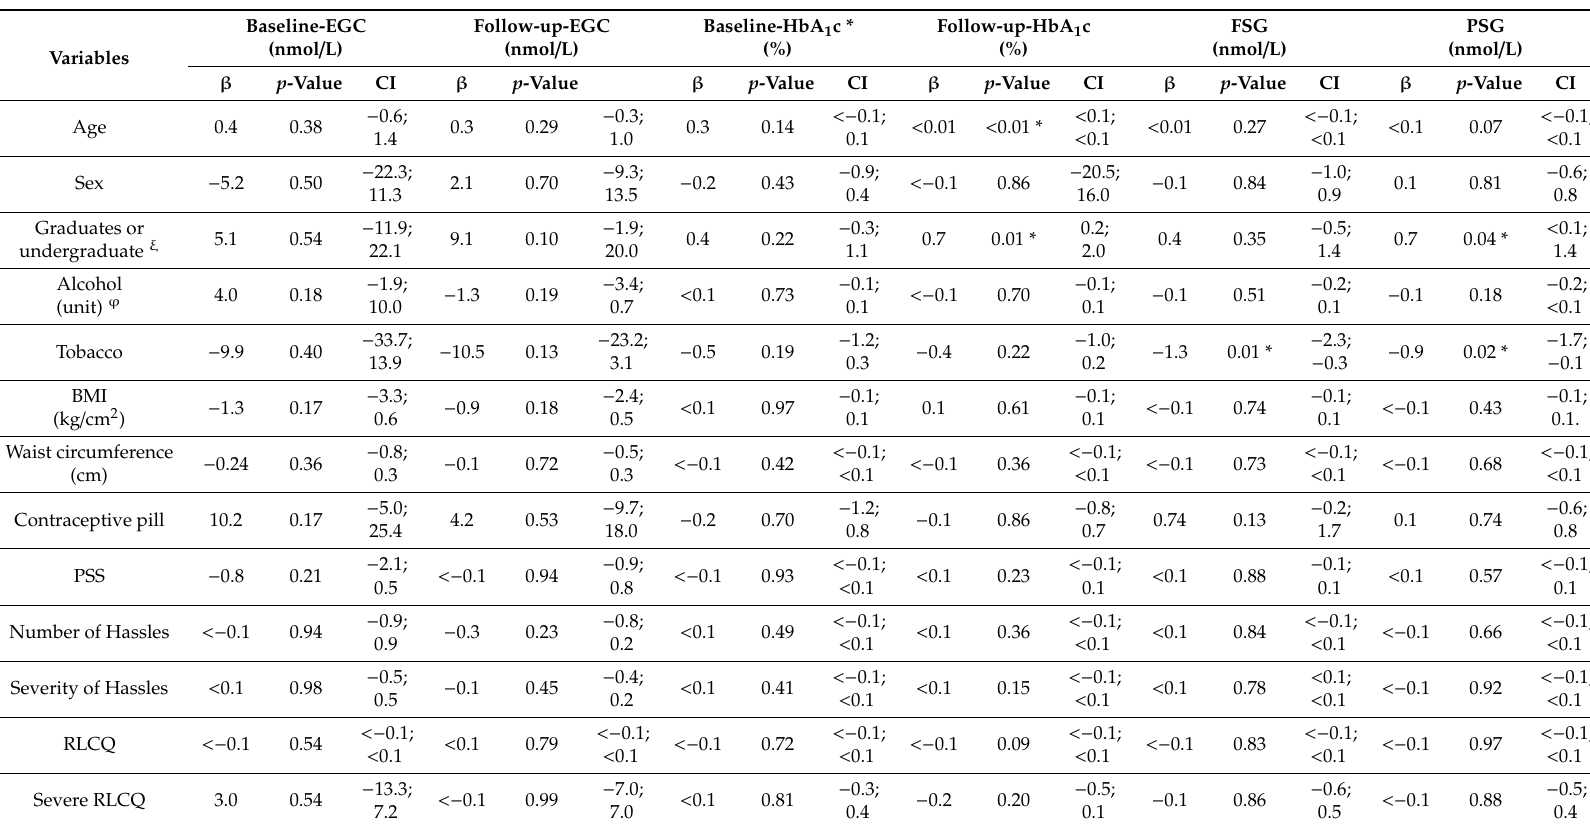
Table 8. Linear regression models between several covariates and baseline and follow-up samples of earwax, glycemic and HbA 1c